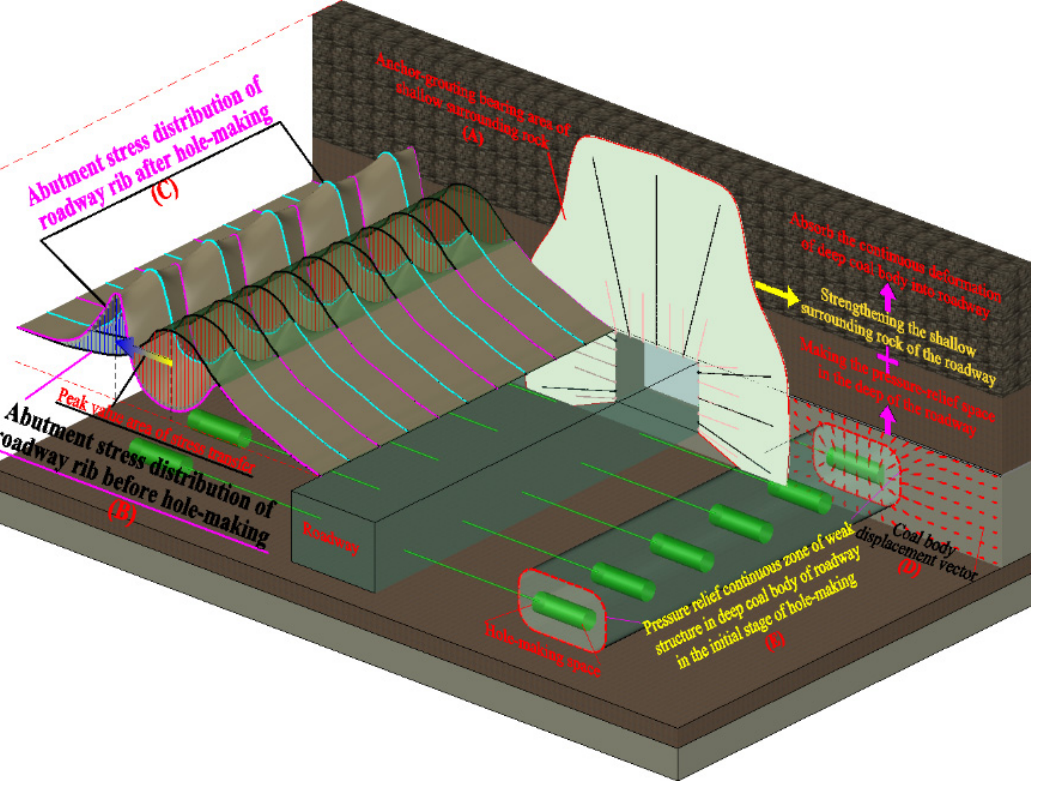
Figure 6. Principle of cooperative control technology of external anchor–internal unloading of roadway surrounding rock.